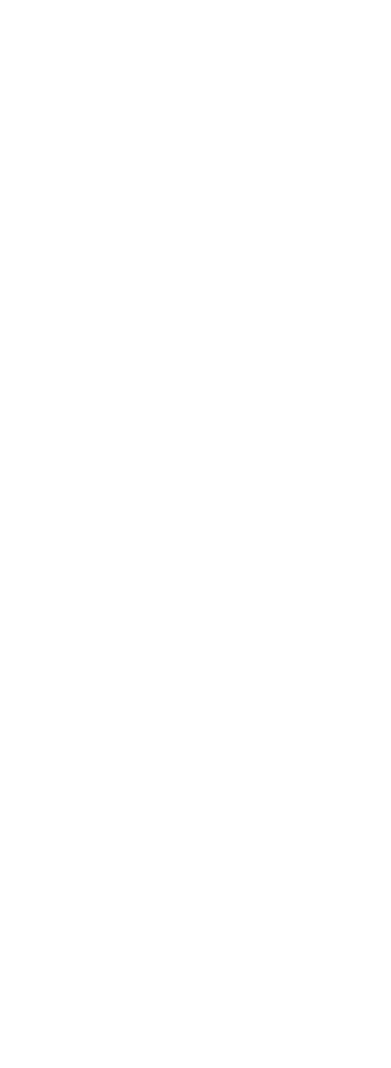
FIGURE 3 Morpholino knockdown of putative zebra fi sh Il1r1 . (A) RT-PCR of cabz , zmp , and actb1 transcripts from uninjected embryos, control morpholino injected embryos, and cabz and zmp morphants. (B) Schematic of the cabz01054965 ( cabz ) gene showing exons 3-6, forward (F) and reverse (R) primers used for analysis (black arrowheads), the location of the splice donor site morpholino (blue line), normal splicing of wt (black lines), and aberrant splicing with the cabz morpholino (red line) that excludes exon 4 (-ex4). (C) Schematic of the zmp:0000000936 ( zmp ) gene showing exons 4-8, forward (F) and reverse (R) primers used for analysis (black arrowheads), the location of the splice donor site morpholino (blue line), normal splicing of wt (black lines), and aberrant splicing with the zmp morpholino (red lines) that includes intron 5 (+in5), introduce a cryptic splice sites (css), or excludes exon 5 (-ex5). (D) Diagram of the experimental paradigm used to functionally identify zebra fi sh Il1r1. A zebra fi sh model of Il- 1 b -induced systemic in fl ammation was generated by breeding transgenic lines ubb:Gal4-EcR and uas:Il b mat with or without the neutrophil reporter line mpx:mCherry . Single-celled embryos were injected with morpholino, in fl ammation was induced with 1 µM Tebufenozide (Teb) at 1 or 2 dpf, and functional analyses were performed from 3-6 dpf to assess morpholino rescue of Il-1 b -induced in fl